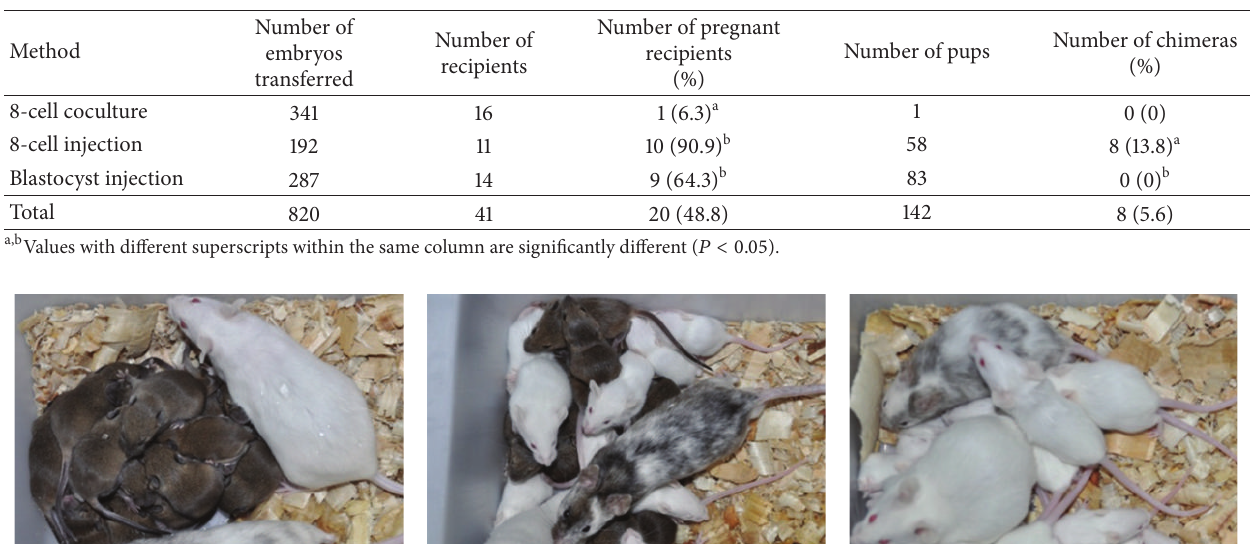
Table 3: Generation of chimeric mice using iPSCs.